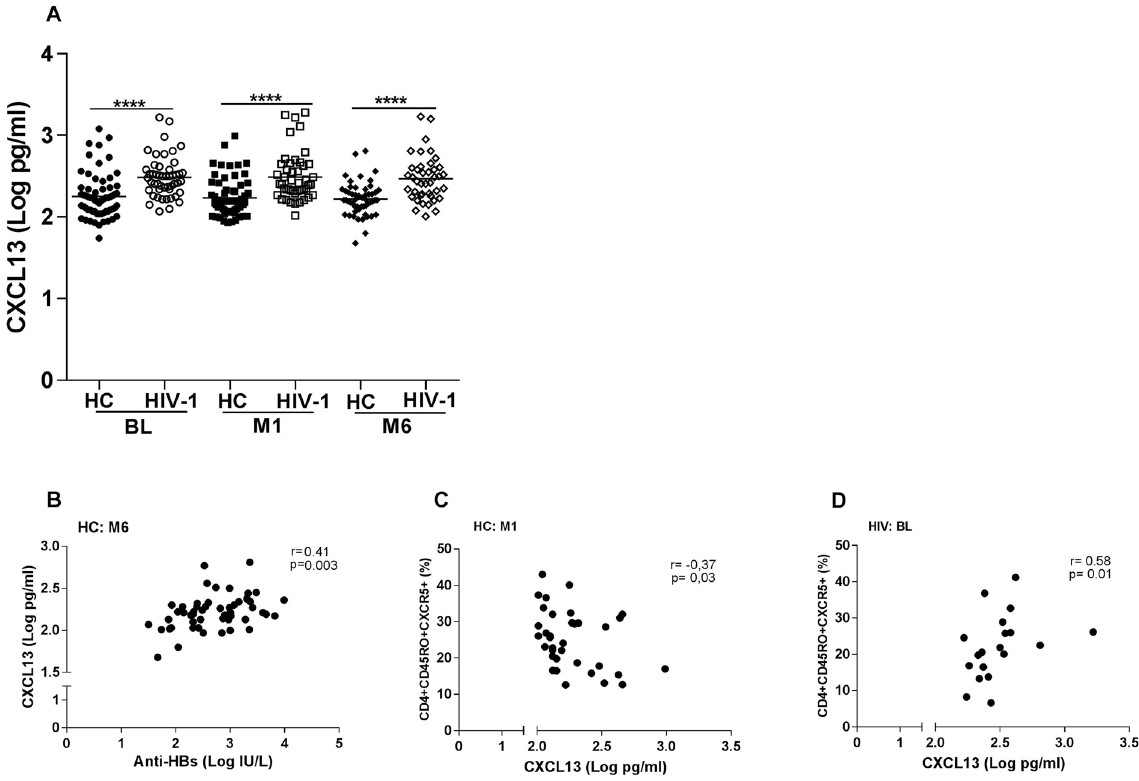
Figure 4. CXCL13 levels in plasma of healthy controls and HIV-1 infected children prior to vaccination and at 1 and 6 months post vaccination. CXCL13 was measured prior to vaccination and at 1 and 6 months post vaccination in specimens from healthy controls (n = 63, 62 and 53) and HIV-1 infected children (n = 49, 47 and 41) ( A ). ANOVA was used to calculate the differences between healthy controls and HIV-1 infected children at the 3 time points. Unpaired T test was also used to calculate the differences between healthy controls and HIV-1 at individual time points. The lines represent the median values in the figures. **** p < 0.0001. A correlation was found between the plasma levels of CXCL13 and anti-HBs abs at 6 months from the last vaccination in healthy controls (panel B: n = 53). A significant correlation was found in the group of healthy controls at 1 month post vaccination (C; n = 35) and HIV-1 infected children when comparing the levels of plasmatic CXCL13 expression and frequency of cTfh cells at baseline (D; n = 19). HIV = HIV-1 infected children; HC = healthy controls.